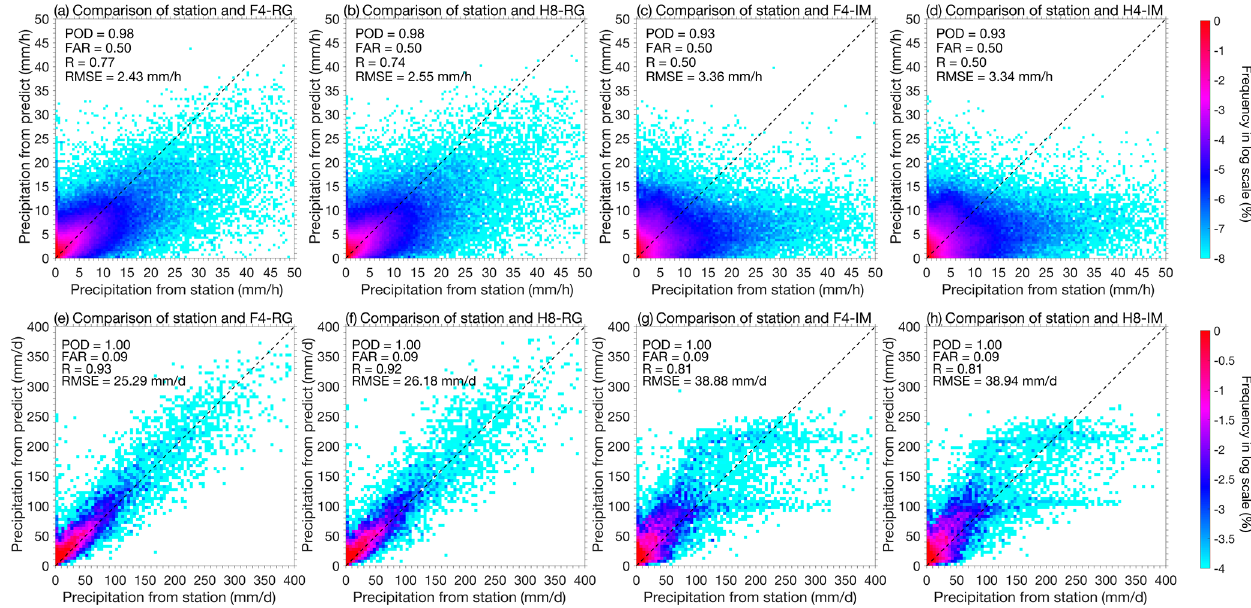
Figure 11. Probability density distributions of the hourly (a–d) and daily (e–h) precipitation of F4-RG, H8-RG, F4-IM and H8-IM during three typhoon events. The dotted black line in all panels represents the 1:1 line.